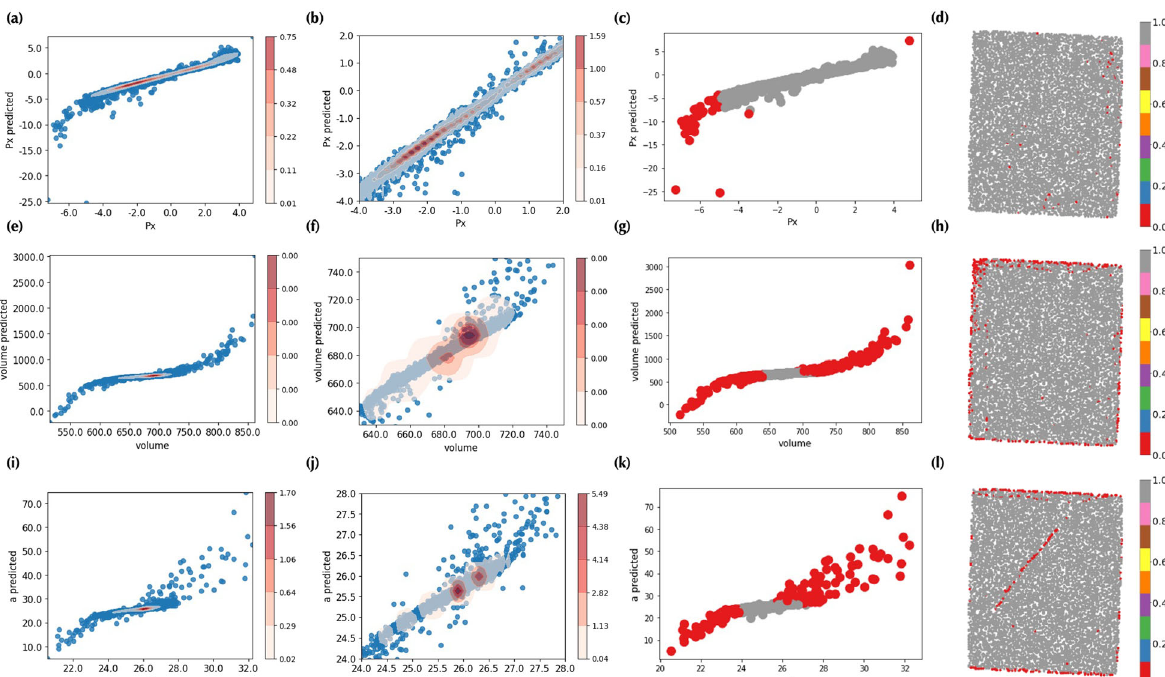
Fig. 2 DCNN-predicted polarization. DCNN predicted vs. measured polarization, P x , component in a full and b zoomed-in scale. DCNN predicted vs. measured projected unit-cell volume in e full and f zoomed-in scale. DCNN predicted vs. measured unit-cell size in i full and j zoomed-in scale. The anomalous regions along with their respective spatial locations (both marked in red) associated with the predictions are also shown in c , d , g , h , and k , l for measured P x , measured unit-cell volume and measured unit-cell size, respectively.